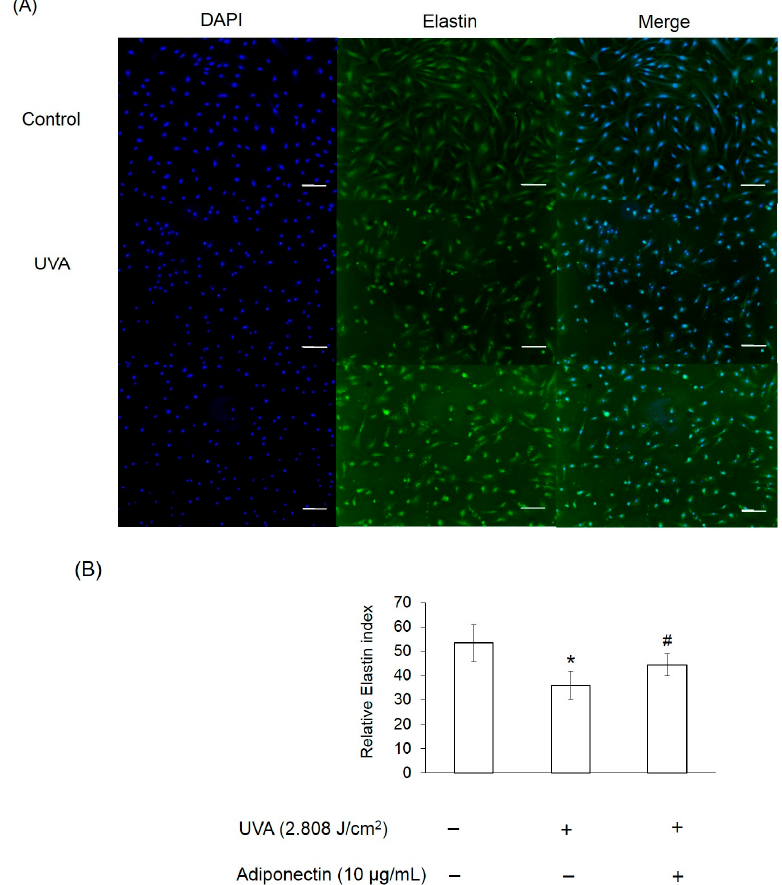
Figure 10. The effect of adiponectin on elastin expression in UVA-irradiated Hs68 fibroblasts. ( A ) Immunofluorescence staining of Hs68 fibroblasts using specific elastin antibody (green fluorescence, ×100 magnification, Scale bar = 200 μ m); and ( B ) quantification of immunofluorescence staining of Hs68 fibroblasts. Green fluorescence staining indicates the presence of elastin. Blue staining illustrates the DAPI nuclei counterstain. * p < 0.05 with respect to control; # p < 0.05 with respect to UVA.